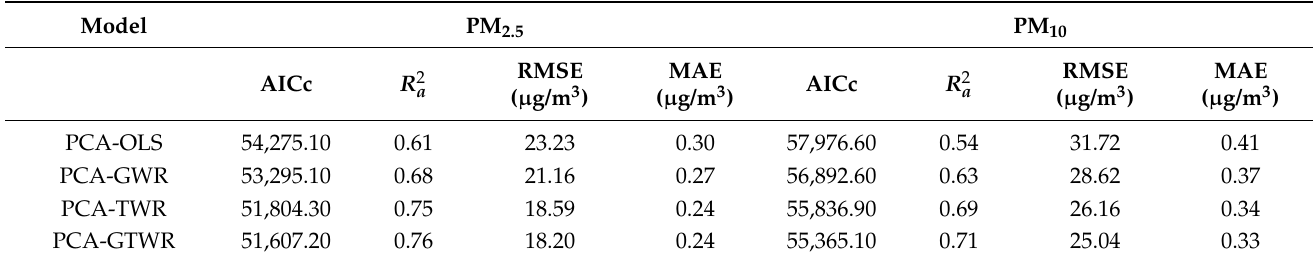
Table 6. Comparison of PCA-OLS, PCA-GWR, PCA-TWR,